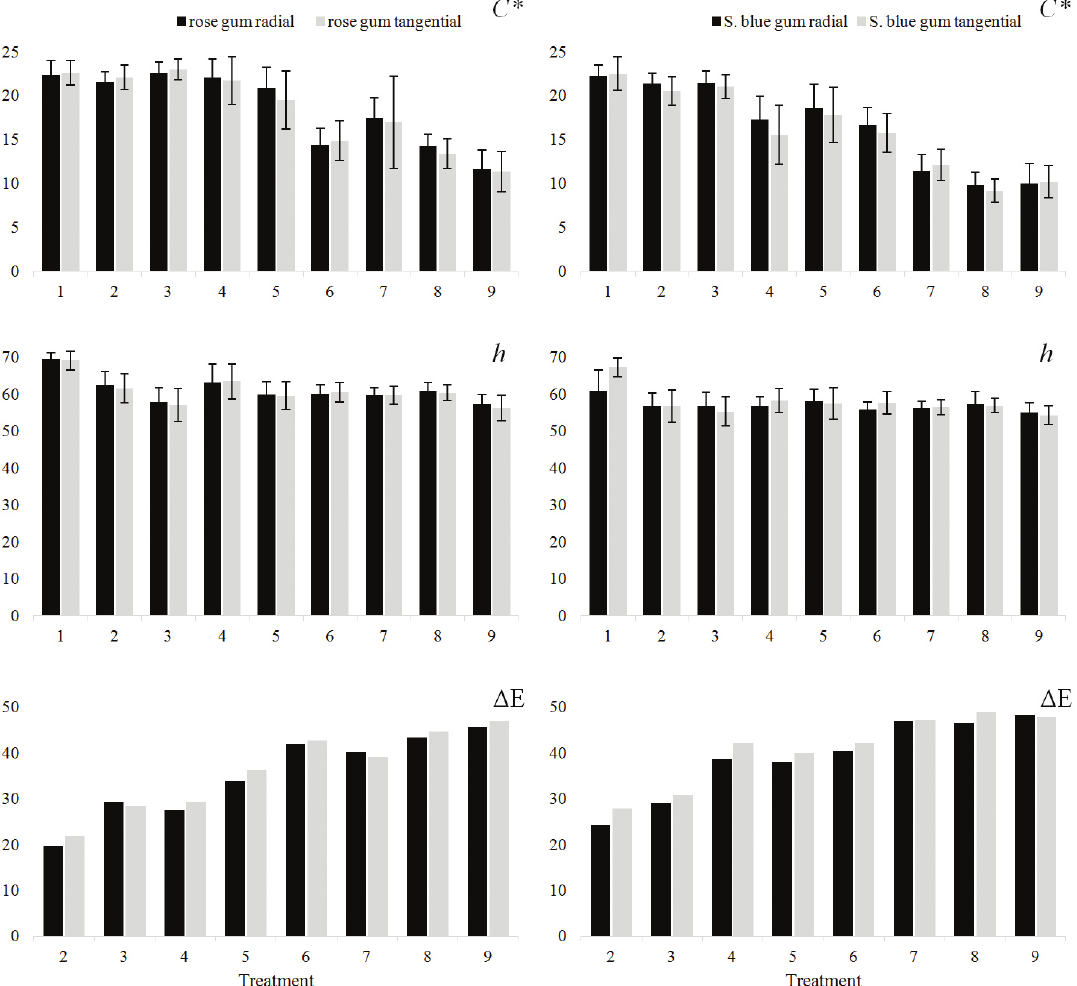
Figure 3. Average values of parameters C*, h and Δ E in radial and tangential direction of rose gum and Sydney blue gum untreated and thermally treated wood